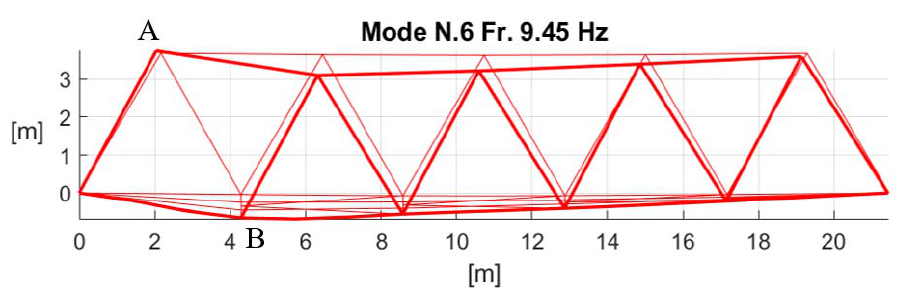
Figure 14. Local mode shape arising when the damaged diagonal member is positioned in the first module of the truss bridge (the missing AB diagonal member represent the damaged element).